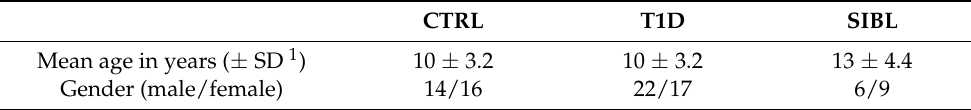
Table 1. Study cohort’s characteristics.